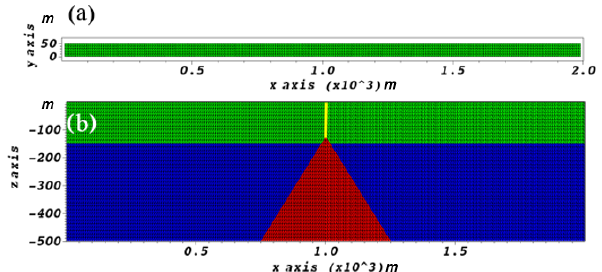
Figure 1. Conceptual schematization of geological setting (a) Plan view of the model grid in this case. (b) Vertical view of the grid. The height of rock ridge (red areas) is 375m.